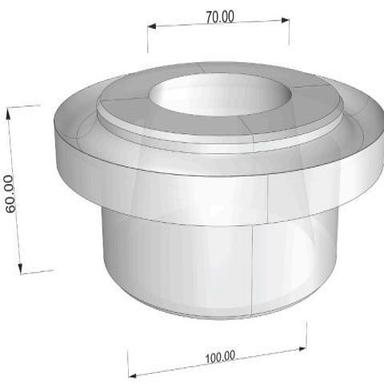
The modified cone shape with the dimensions of the "H¨ agermann" mini-cone.